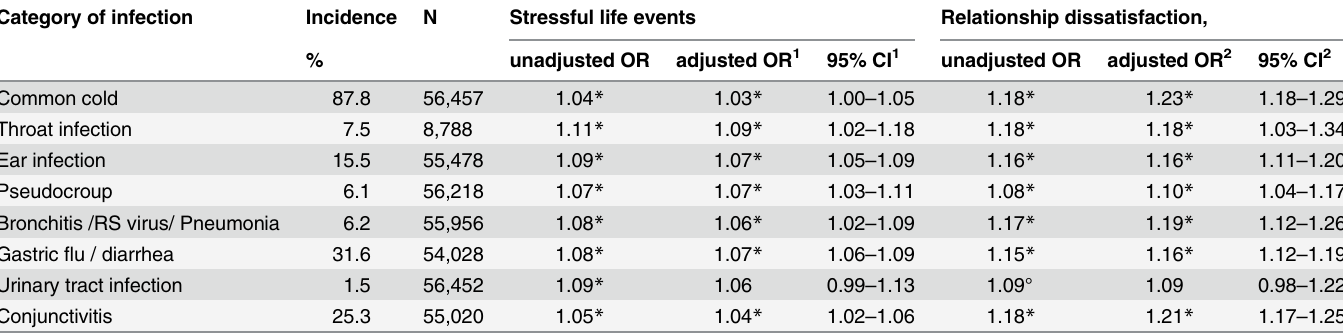
Table 2. Associations between stressful life events and relationship dissatisfaction in pregnancy, and infectious diseases in the 6- to 11-month- old